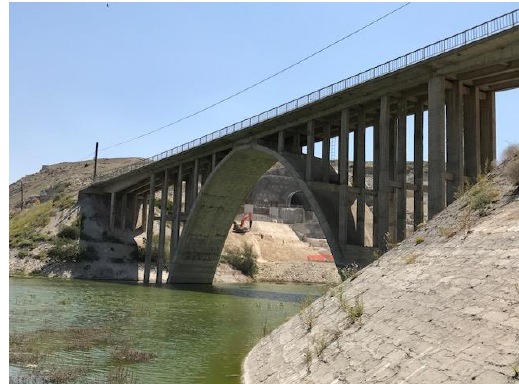
Figure 1: The image of the Çayırhan Bridge.